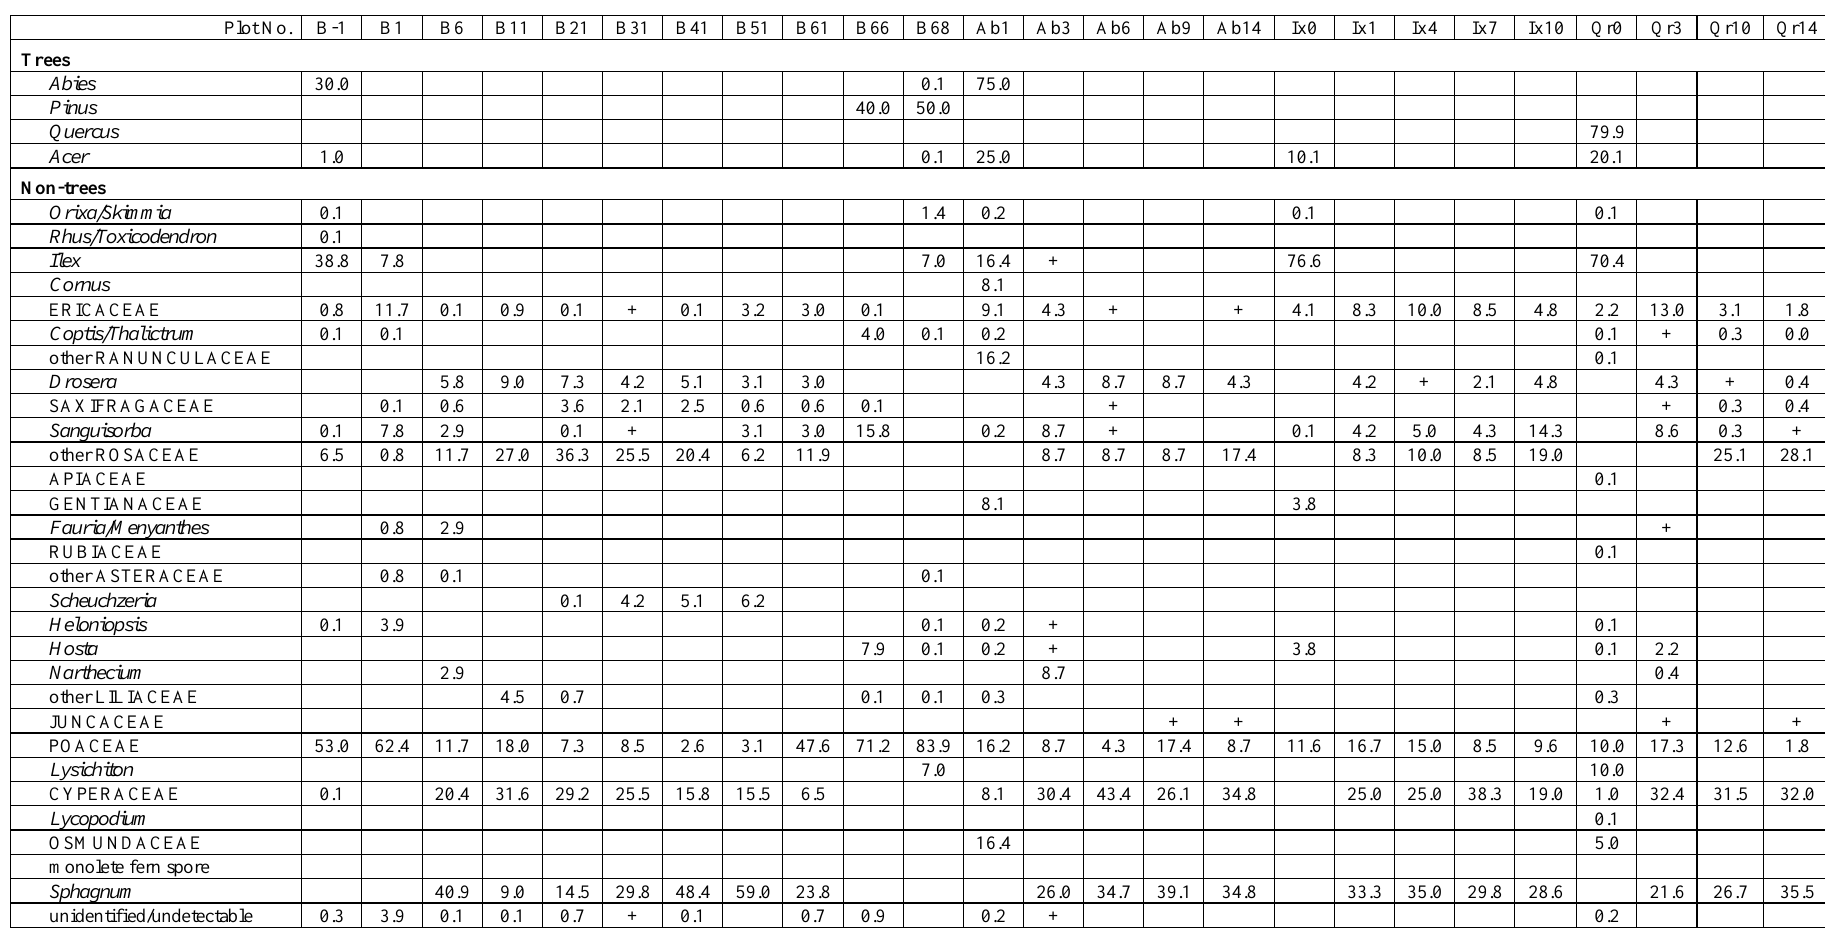
Table A2. Species composition of the plots on Lines B, Ab, Ix and Qr in Takada-yachi Mire. The relative cover of each taxon is summarised for those categories coinciding with the pollen type. The extent of species dominance is shown as original percent coverage for trees and relative coverage for non-trees. Plot